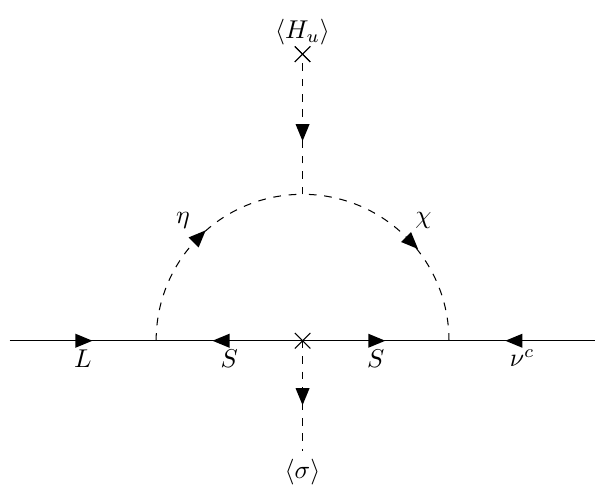
Figure 1 . Neutrino Dirac masses from \scotogenic" loop